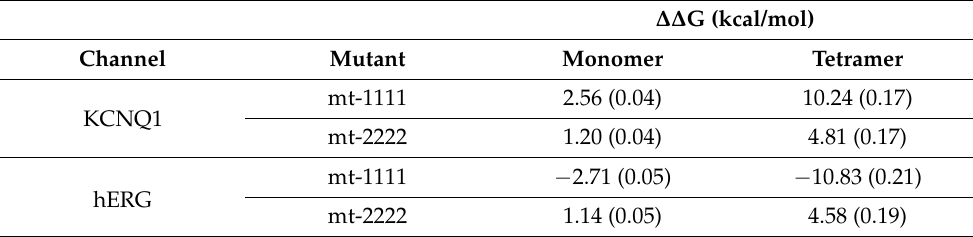
Table 1. Mutation free energy (monomer and tetramer). Values in parentheses are mean standard errors. KCNQ1: Mutant 1 = p.Ala300Thr; Mutant 2 = p.Ala344Val. hERG: Mutant 1 = p.Pro507Thr; Mutant 2 =